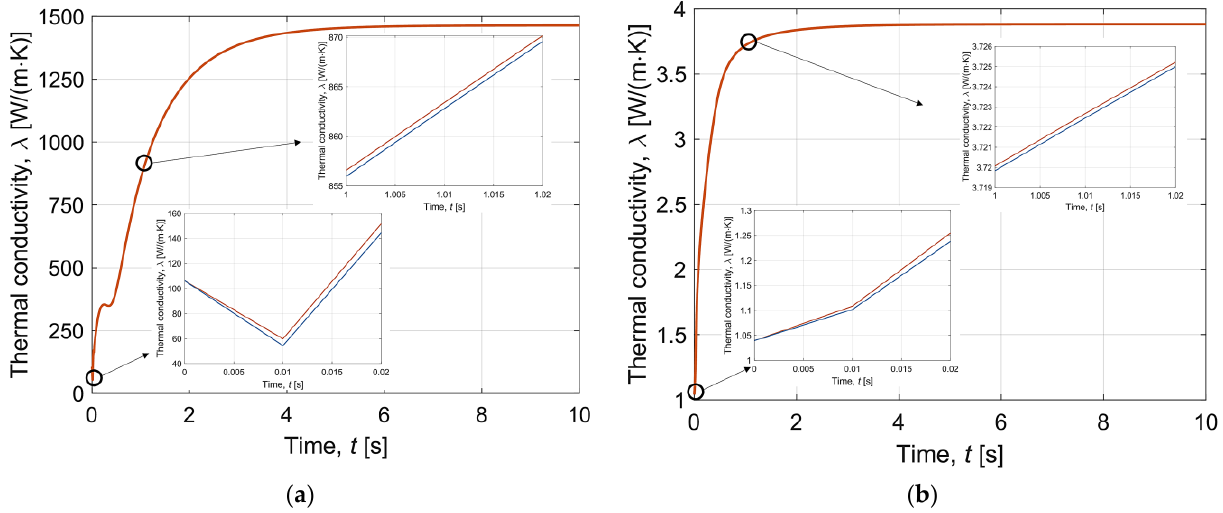
Figure 4. Interval thermal conductivity as a function of time during cooling for ( a ) chip wall; ( b ) sample layer.